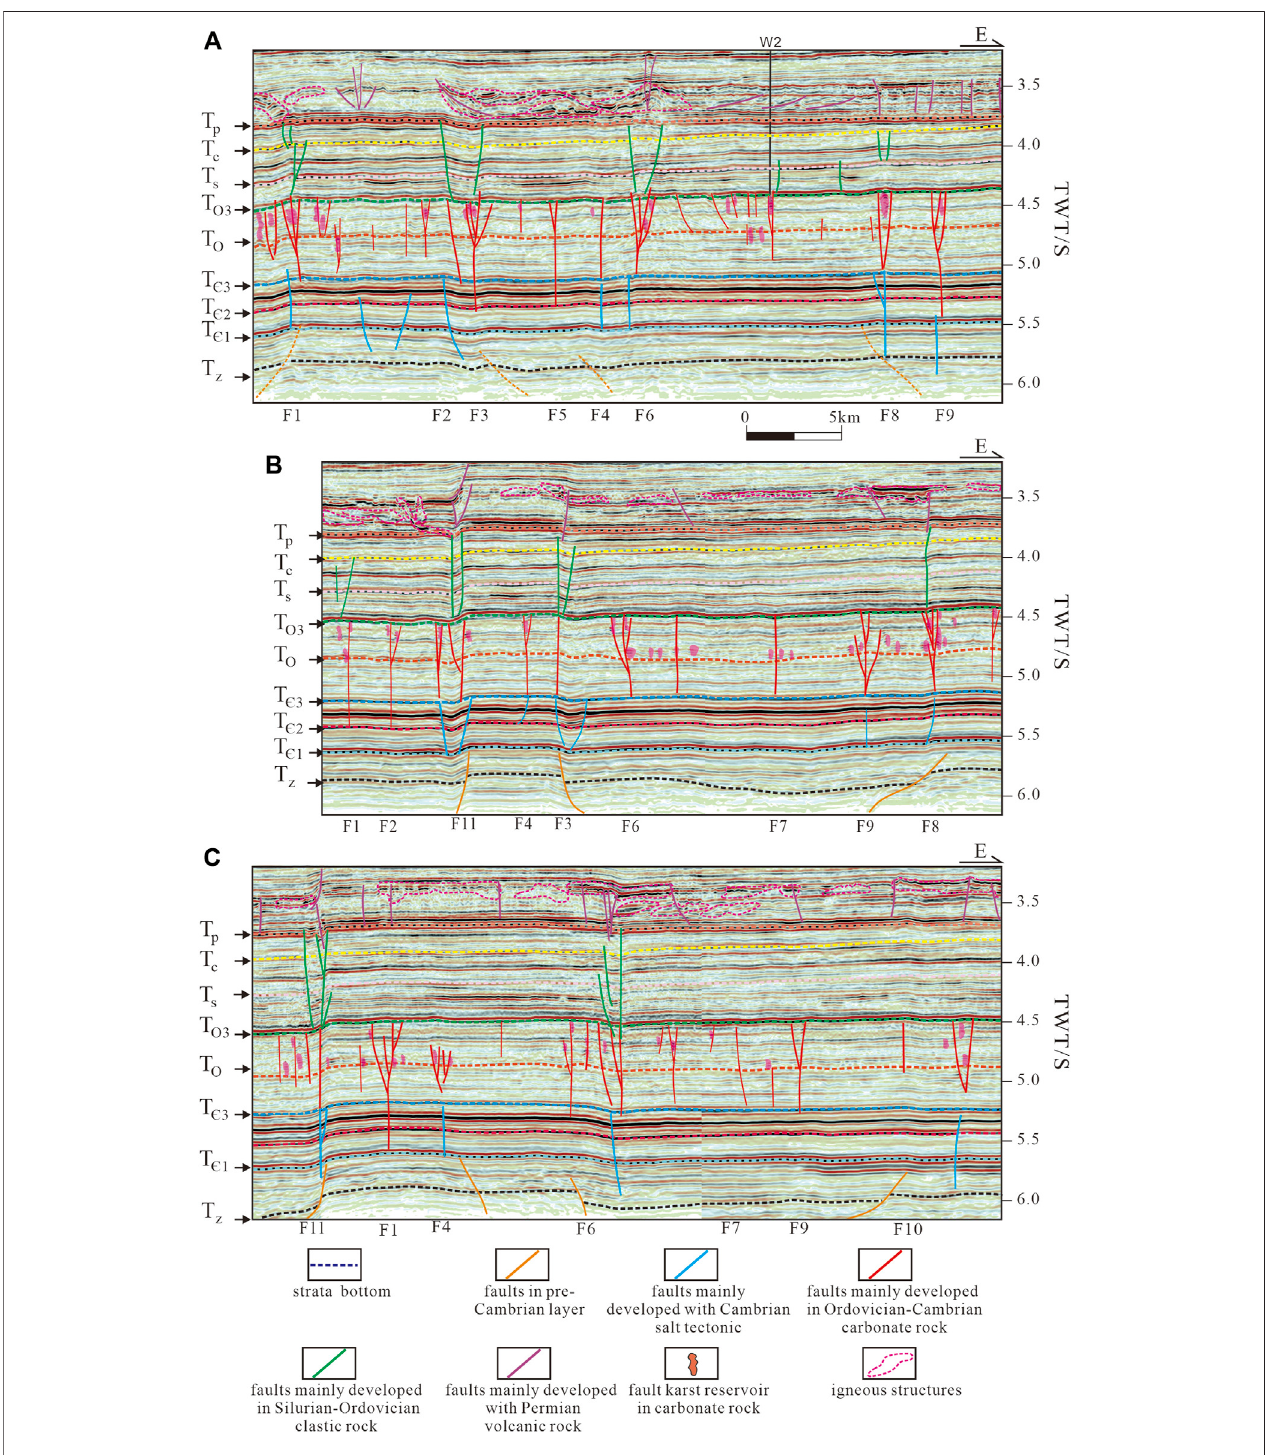
FIGURE10| 3Dseismicpro fi lesoftheTabeiuplift(forlocation, see Figure9 ): (A) 3Dseismiclineofthenorthernpart (L-1), (B) 3Dseismiclineinthecentralpart(L- 2), and (C) 3D seismic lines of the southern part (L-3). Please refer to the supplementary materials for the uninterpreted seismic data.